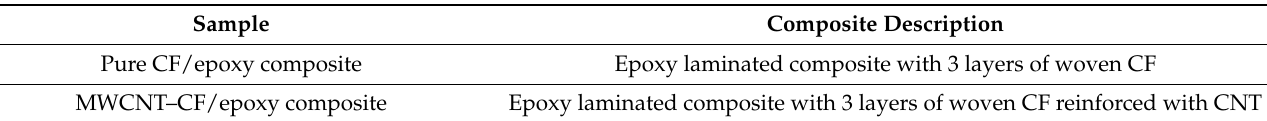
Figure 2. Schematic illustration of composites and their dimension. Table 5. Description of the